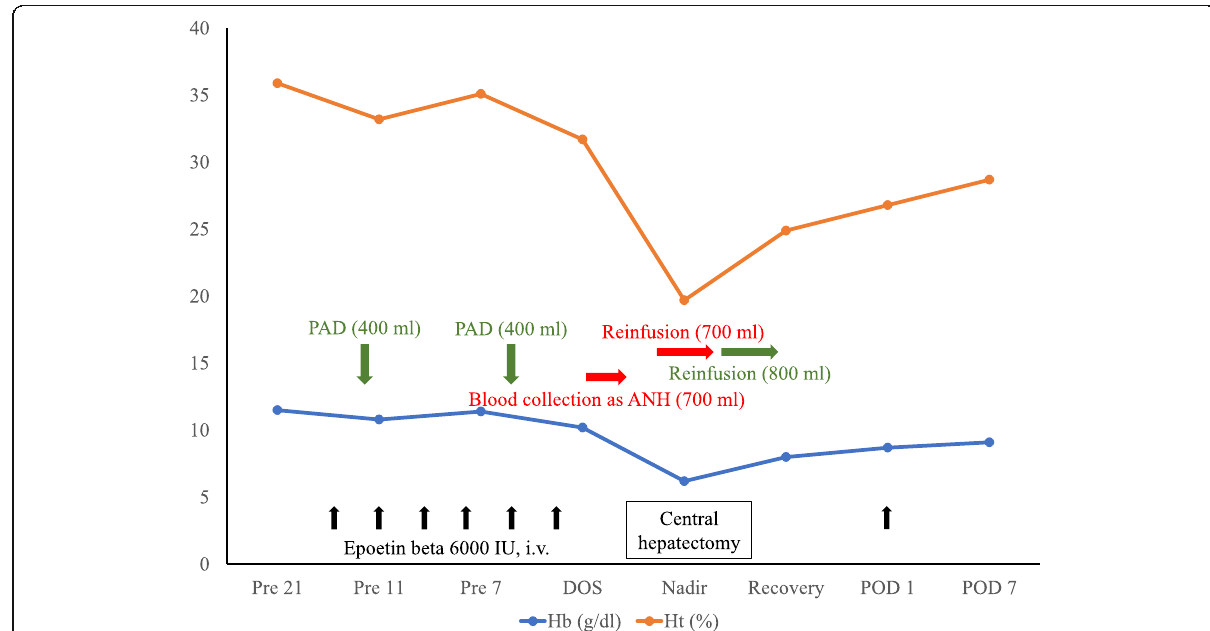
Fig. 3 Peri- and intra-operative course of Hb and Ht values with description of PAD and ANH under erythropoietin therapy. Hb: hemoglobin; Ht: hematocrit; PAD: preoperative autologous donation; ANH: acute normovolemic hemodilution; Pre: preoperative day; DOS: day of surgery; Nadir: intraoperative hemoglobin nadir; Recovery: in recovery